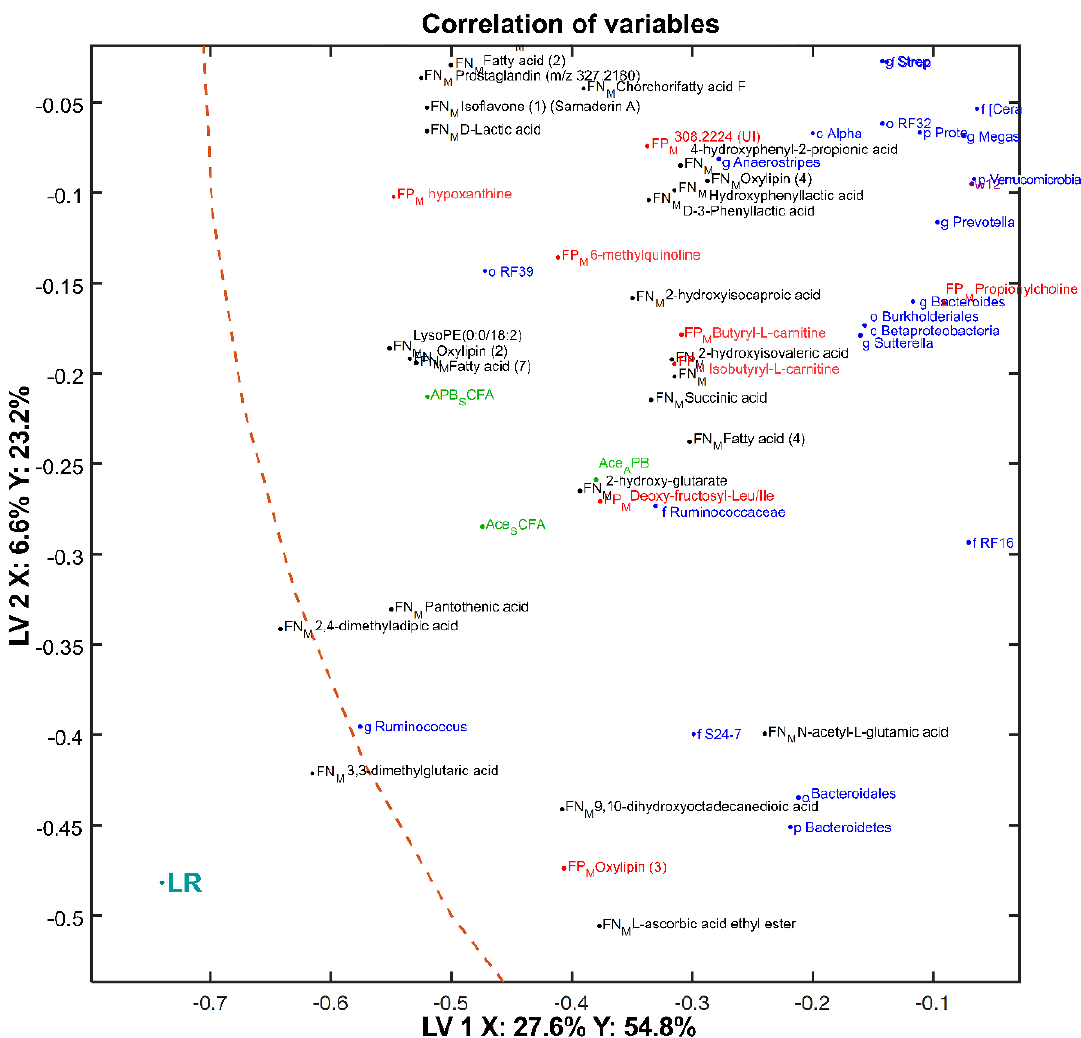
Figure 11. A detailed view of the correlation loading plot focusing on variables strongly associated with the LR diet (for a global overview of the correlation plot, we refer to Figure S5). Scores of a 4-block model: fecal ESI+ metabolomics (FP M , red), fecal ESI − metabolomics (FN M , black), SCFAs (green), metataxonomics (blue) are used to plot the correlations. The first two components are shown with the explained variances in sample matrix X and the dietary treatment Y. Abbreviations: g, genus; f, family; o, order; k, kingdom; p, phylum; c, class; UI, unidentified compounds.